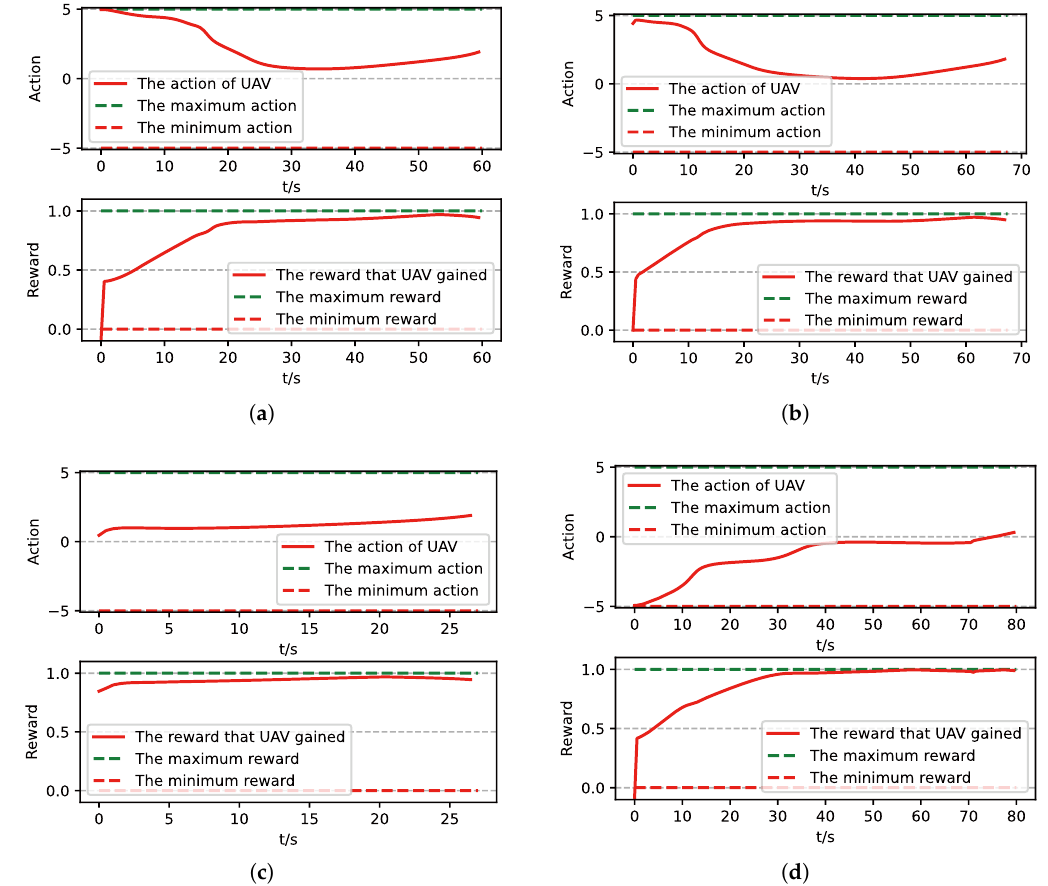
Figure 20. The parameters curve from MC experiments for the trained result of PER-DDPG: ( a ) The parameters curve of 1st experiment. ( b ) The parameters curve of 2nd experiment. ( c ) The parameters curve of 3rd experiment. ( d ) The parameters curve of 4th